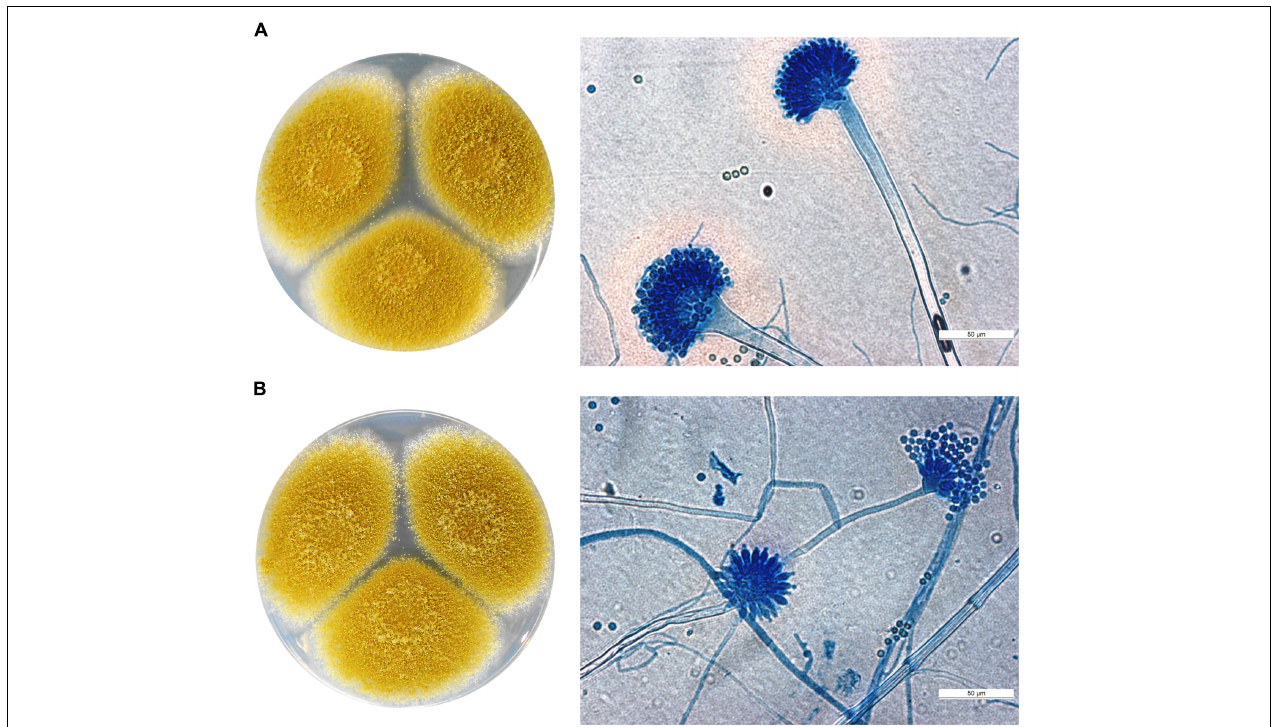
FIGURE 1 | Macro- and micromorphology (after lactophenol cotton blue staining) of A. tamarii (A) SZMC 2439 and (B) SZMC 2393 grown on potato dextrose agar plates for 5 days at 37 ◦ C. Scale bar: 50 µ m.